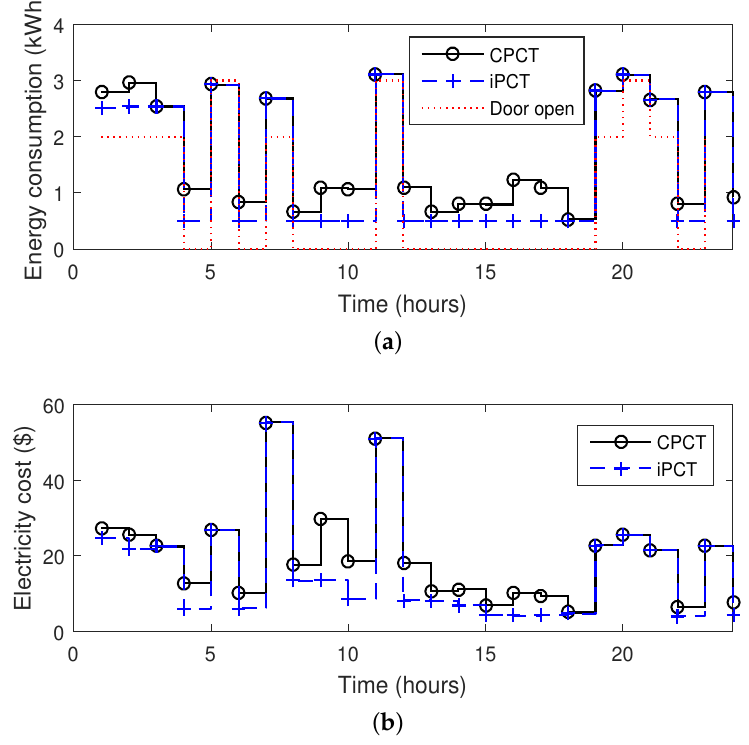
Figure 10. Comparison of energy consumption and electricity cost of refrigerator in unscheduled and unscheduled cases, (door open—total number of door open attempts): ( a ) energy consumption of refrigerator; and ( b ) daily electricity cost of